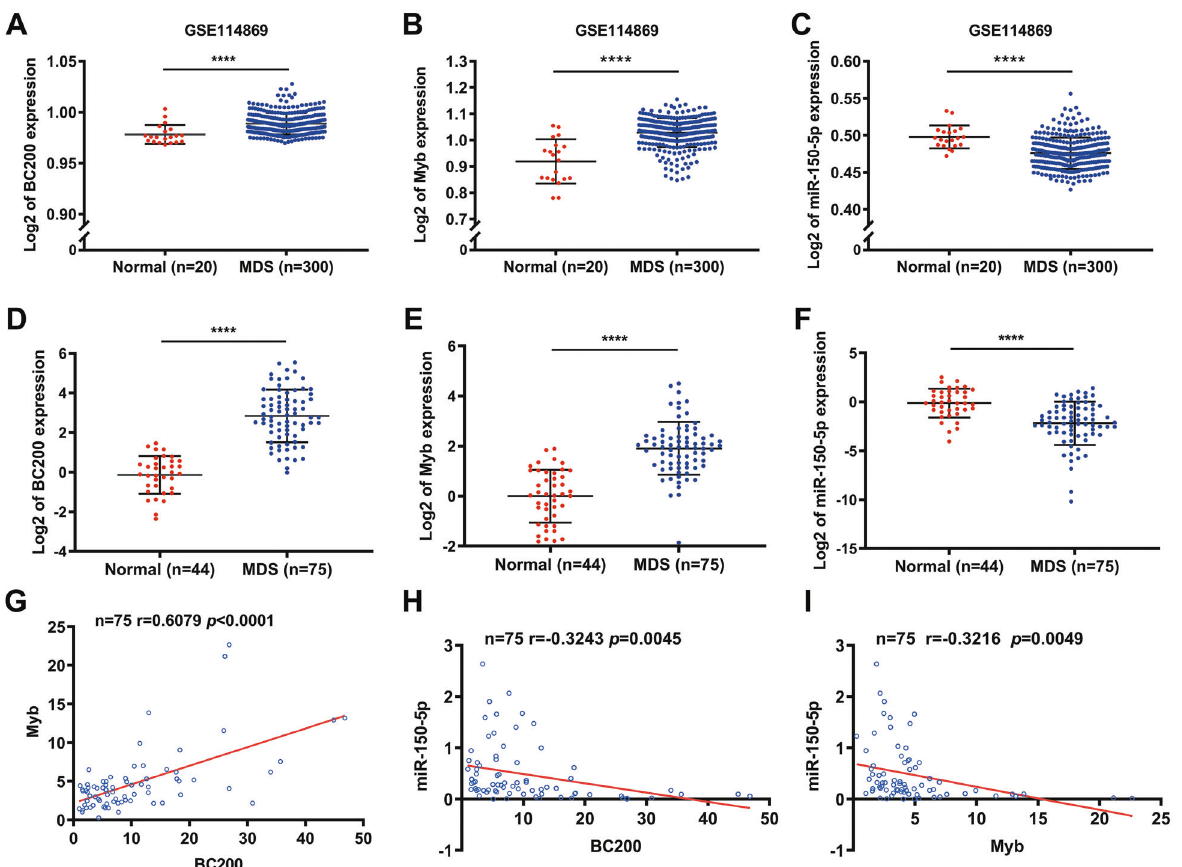
Fig. 7 Clinical signi fi cance of the BC200/miR-150-5p/MYB loop based on bioinformatics analysis. A – C Analysis of a GEO dataset (GSE114869) indicated that BC200 and MYB expression was markedly higher in MDS samples than in normal samples. Conversely, miR-150-5p was signi fi cantly lower in MDS samples. D – F The expression of BC200, miR-150-5p mRNA, and MYB was analyzed by qRT-PCR in 79 MDS samples and 44 normal samples. G – I Correlation analysis of BC200 and miR-150-5p, MYB and miR-150-5p, and BC200 and MYB expression levels in 75 MDS samples. **** p <